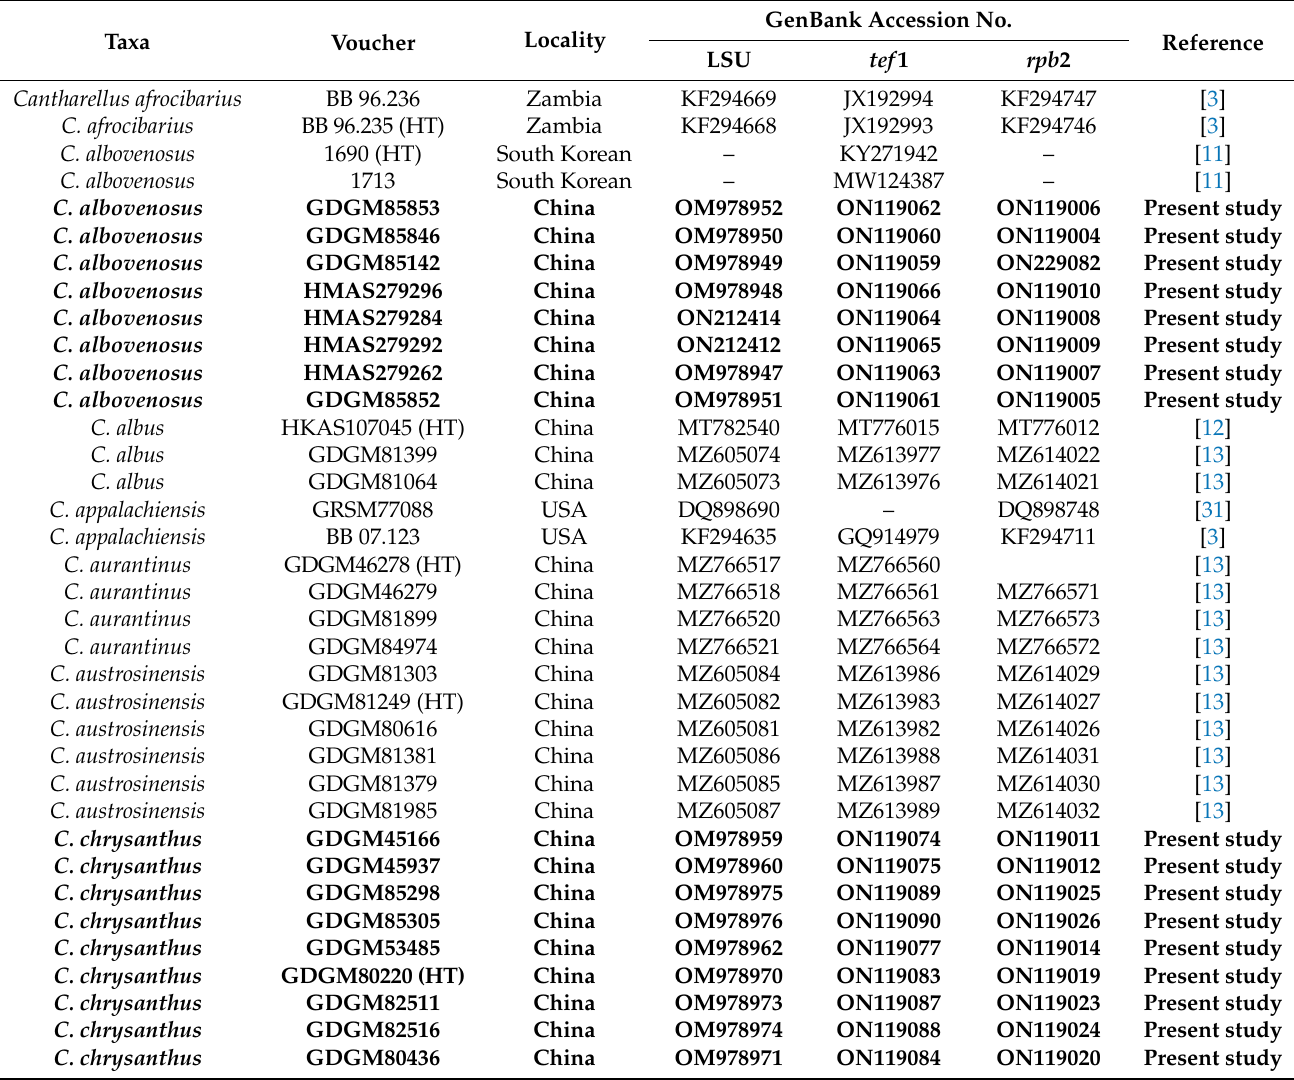
Table 1. Specimen information used in this study. Sequences newly generated in this study are in bold; HT, NT and ET refer to holotype, neotype and epitype,